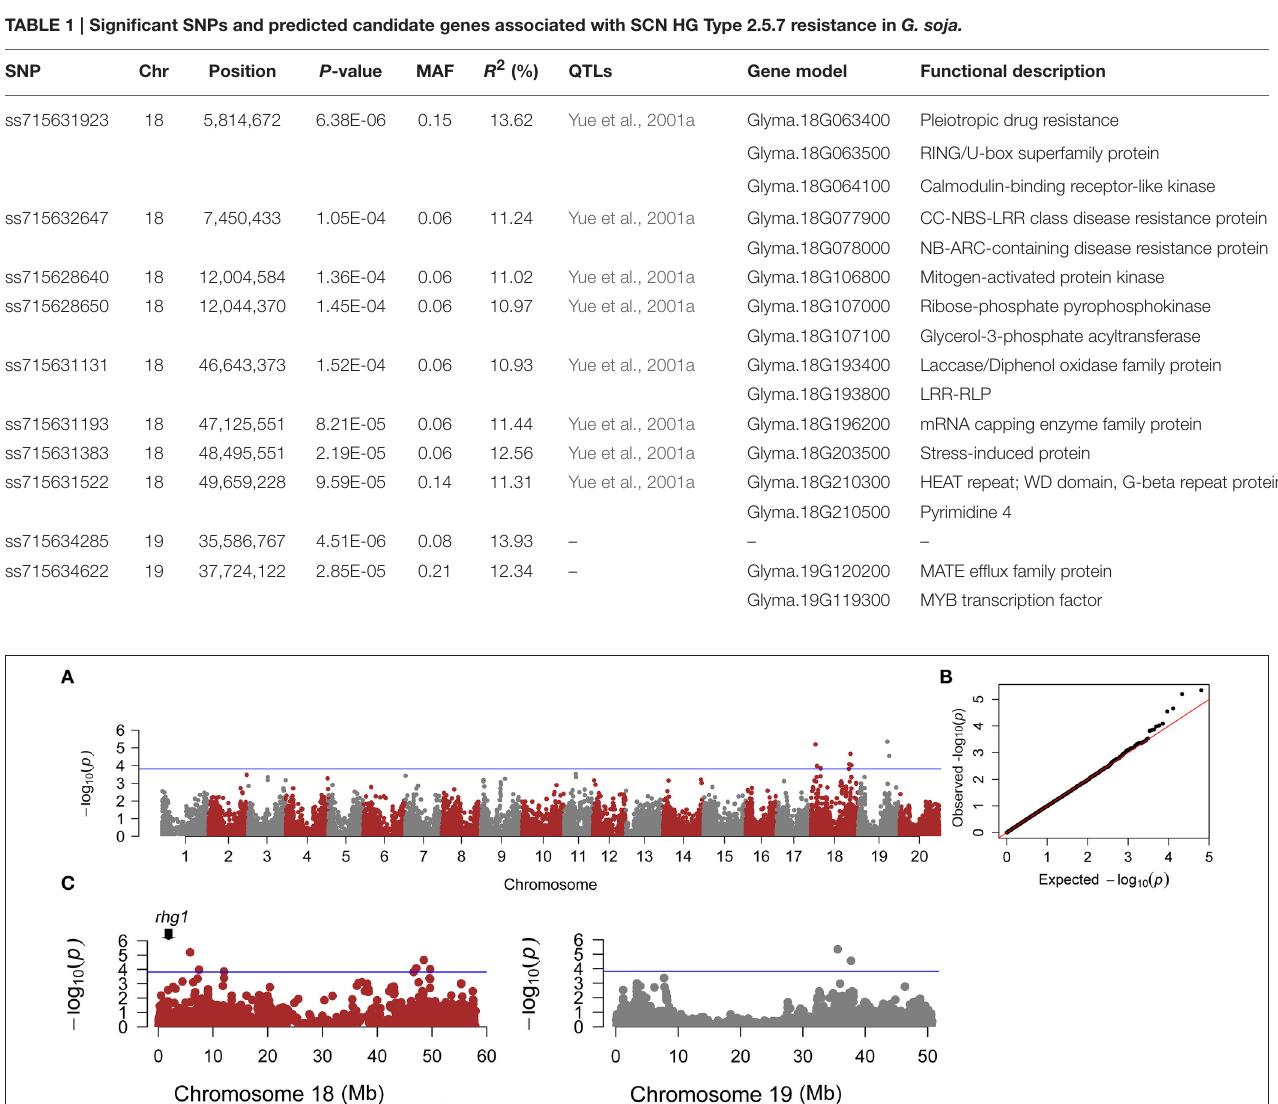
FIGURE 3 | Genome-wide association analyses (GWAS) for SCN resistance. (A) Manhattan plot for SCN resistance. (B) Quantile-Quantile plot using cMLM. (C) Zoomed-in Manhattan plots for chromosomes 18 and 19. The blue line represents the threshold ( P < 10 − 3.81 ) defined by 1000 permutations of the association